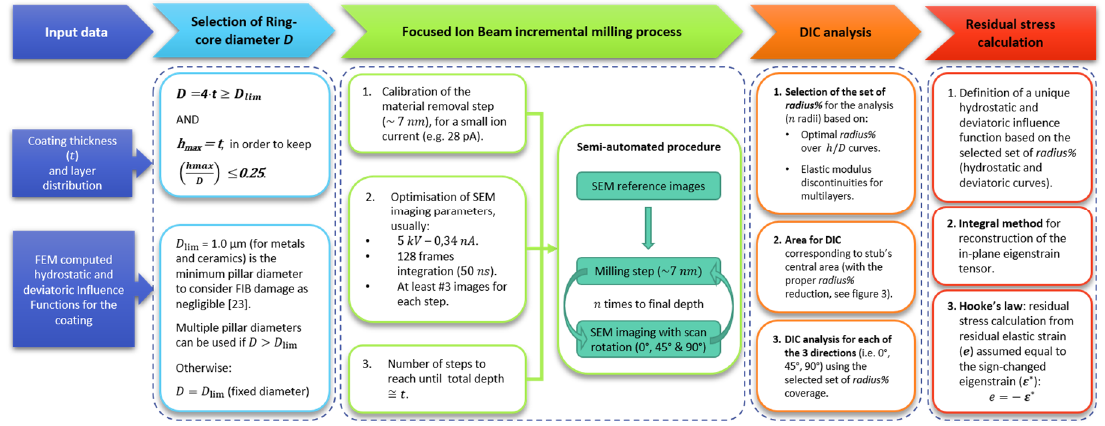
Figure 6. Flowchart describing the entire workflow of the method, with main decision steps on how to select the core diameter, FIB/SEM parameters, DIC analysis, and final residual stress calculation.